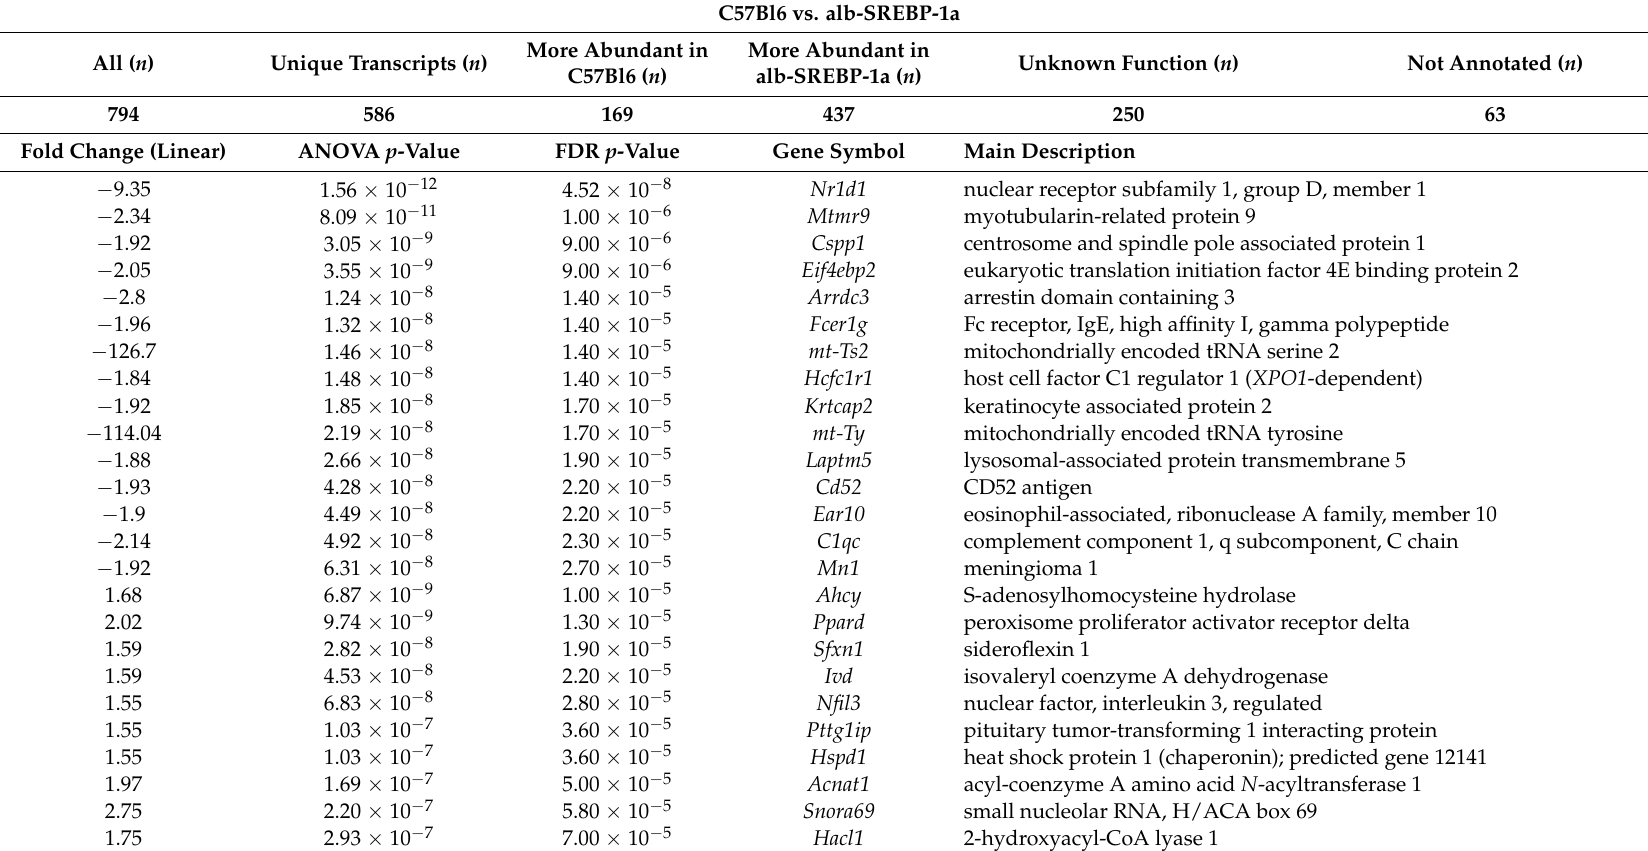
Table 1. Differentially abundant transcripts in the comparisons C57Bl6 vs. alb-SREBP-1a, C57Bl6 vs. alb-SREBP-1a ∆ P and alb-SREBP-1a vs. alb-SREBP-1a ∆ P. The numbers of differential regulated transcripts in the comparisons C57Bl6 vs. alb-SREBP-1a, C57Bl6 vs. alb-SREBP-1a ∆ P, and alb-SREBP-1a vs. alb-SREBP-1a ∆ P and the top 15 up and down regulated molecules with highest significance are shown (only annotated transcripts, negative value: more abundant in condition 1, positive value: more abundant in condition 2. Complete analyses are given in Table S2). Abbreviations are: ANOVA, analysis of variance, FDR, fals discovery